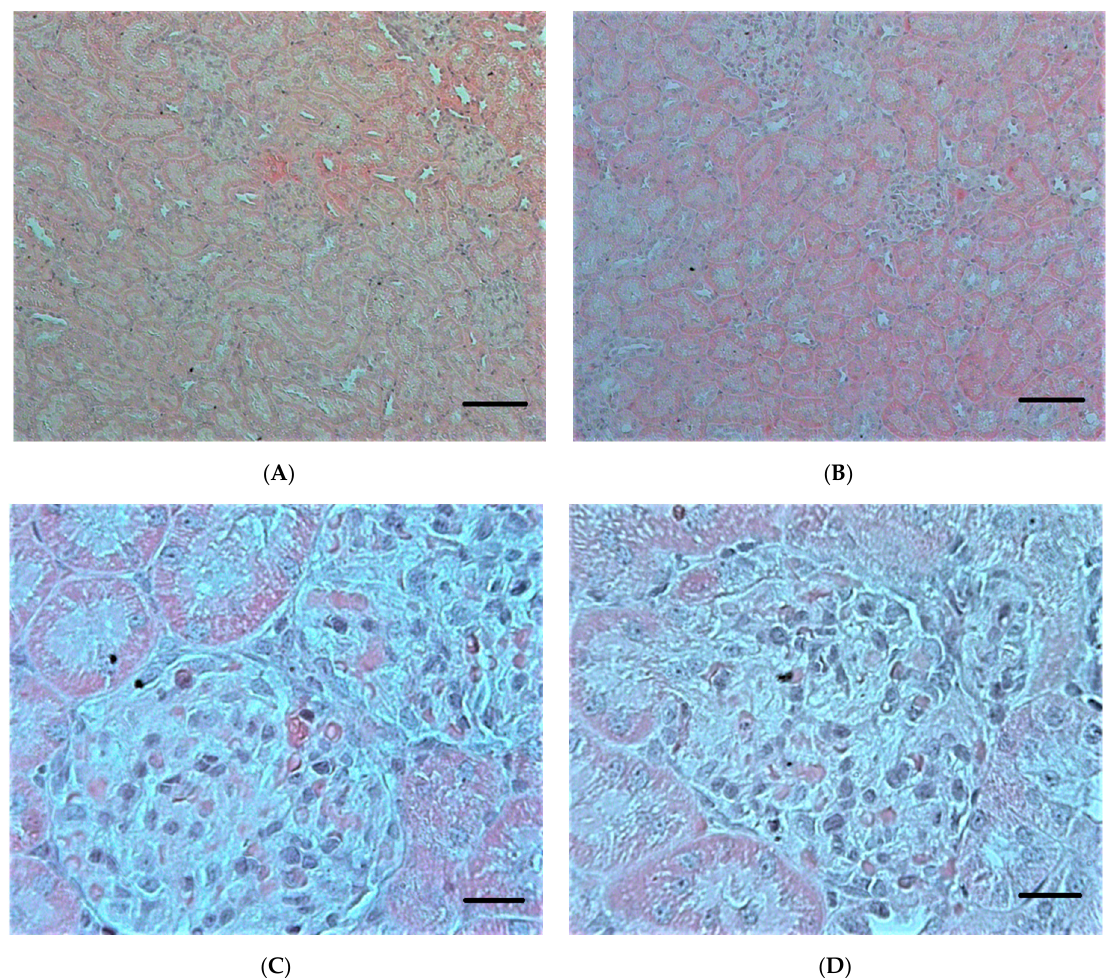
Figure 7. ( A , B )—Expression of nephrin in the kidney cortex 24 h after exposure to POX. ( A )—LD84; ( C )—LD50. ( C , D )— Expression of nephrin in renal cortex cells and tubules 24 h after the exposure at LD50. IHC, fast red chromogen (×200). Scale bar = 100 µm ( A , B ); 10 µm ( C , D ).